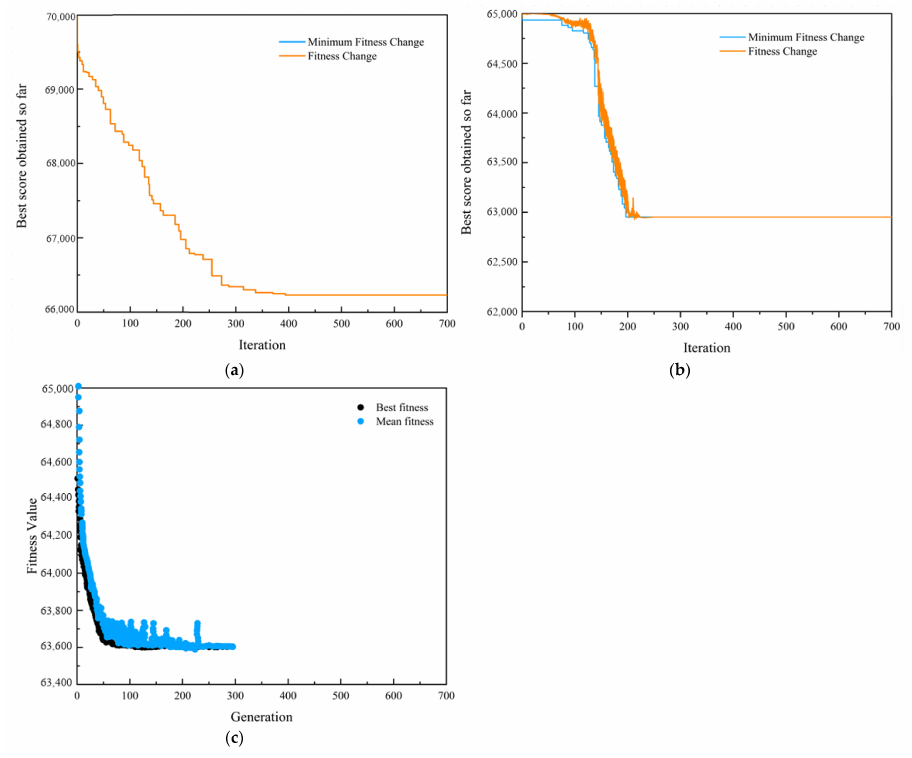
Figure 6. The iterative process of each algorithm when aiming at the lowest warranty cost rate. Figure 6a–c show the convergence curves of the PSO algorithm, SAA and GA, re ‐ spectively, when aiming at the lowest warranty cost rate. Aiming at the maximum avail ‐ ( a ) Convergence curve of PSO algorithm, ( b ) convergence curve of SAA, ( c ) convergence curve of GA. ability, the iterative process of each algorithm is shown in Figure 7.